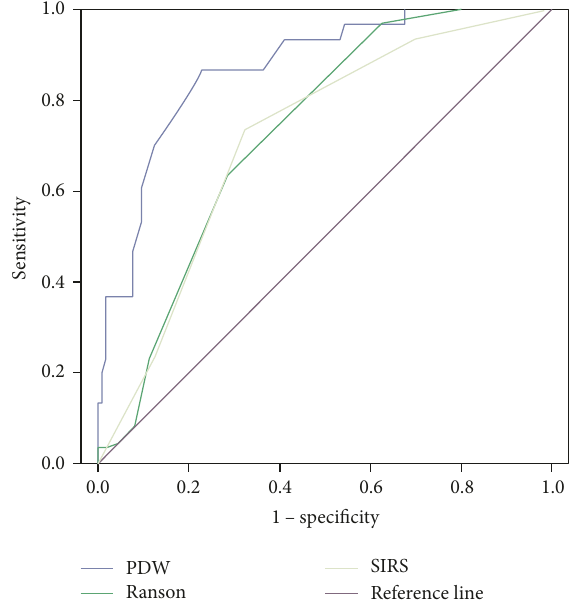
Figure 2: The ROC curve of PDW, Ranson, and SIRS scoring systems in diagnosing POF in